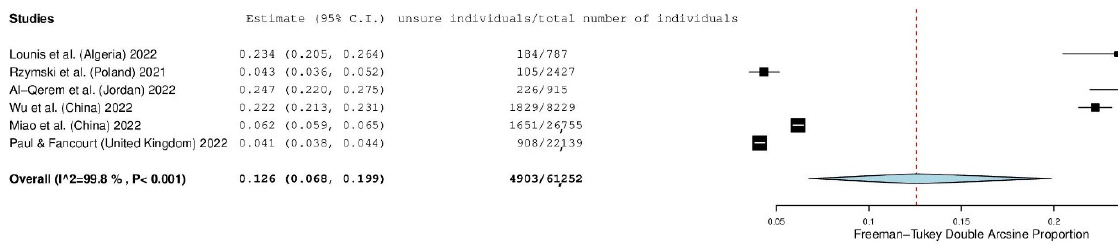
Figure 3. Forest plot of individuals’ refusal to accept a first COVID-19 booster dose. The size of black squares denotes the sample size, while the horizontal line through the square denotes the 95% confidence interval for the refusal proportion.